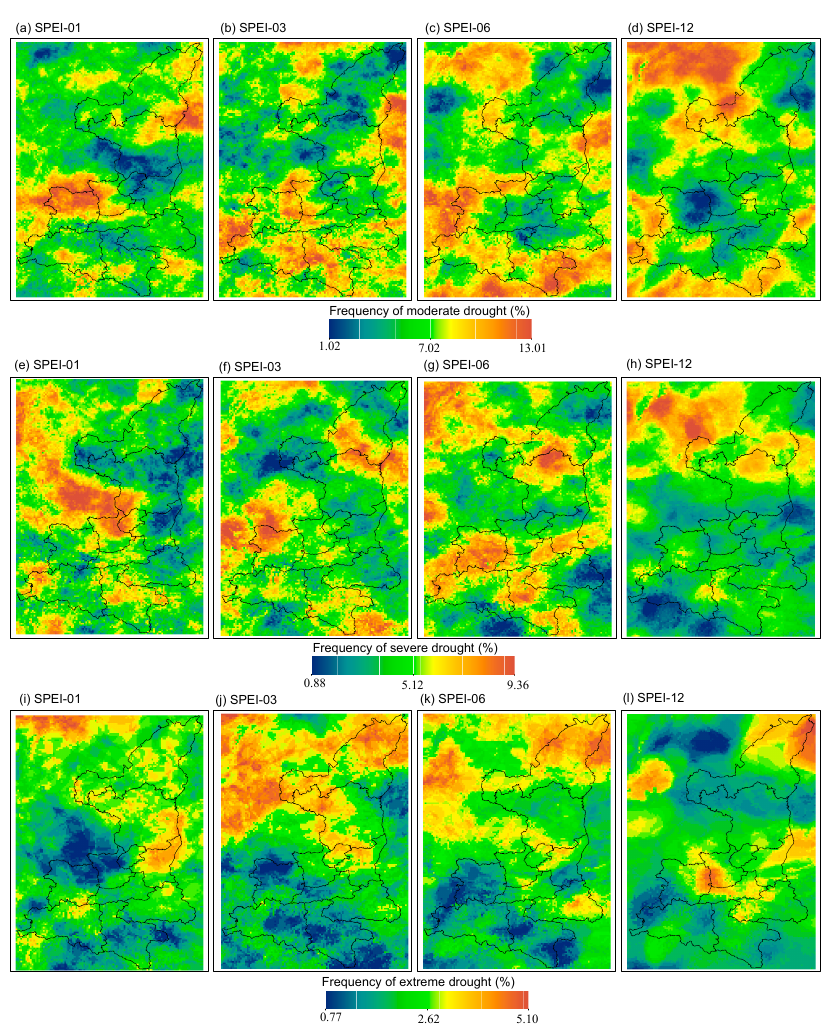
Figure 4. Spatial patterns of frequency in moderate drought months (a–d, –1.0 ≤ SPEI < –1.5), severe drought months (e–h, –2.0 < SPEI ≤ –1.5), and extreme drought months (i-l, SPEI ≤ –2.0) across the study area.